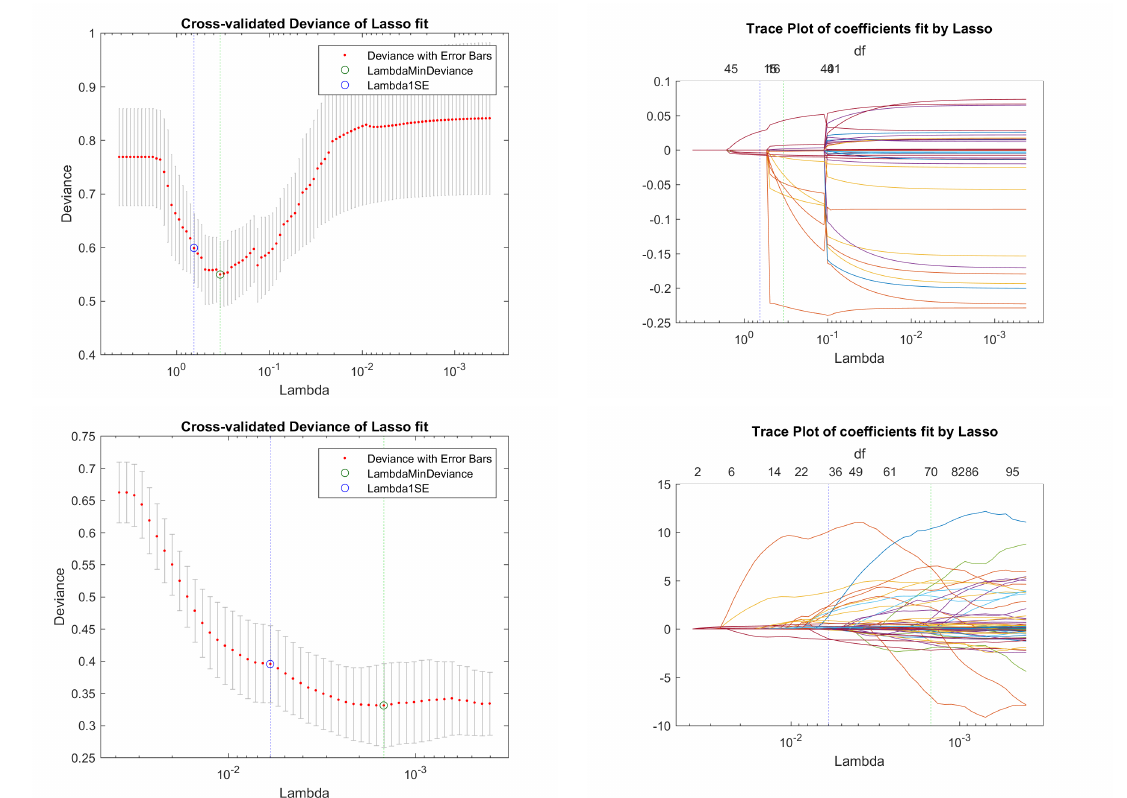
Figure 5. Cross-validation for VXO fits on macroeconomic data . From top to bottom, they are plots of four models with an order of: optimized link function IG GLM LASSO model, three-phase iteratively searched Box–Cox λ BC 3 P transformed Gaussian LASSO model, canonical link IG GLM LASSO model, and response only univariate Box–Cox λ BC transformed Gaussian LASSO